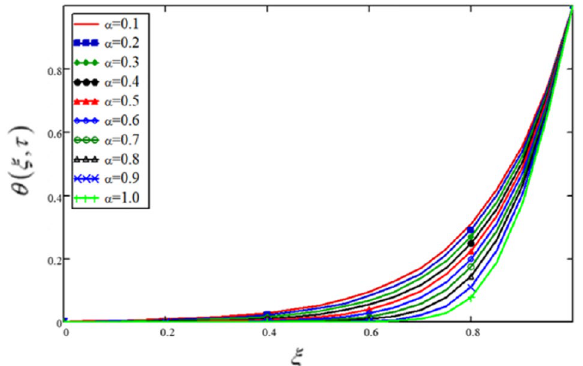
Figure 3. Variations in temperature profile for various values of fractional parameter, the profiles for α = 0.1, 0.2, 0.3, . . . , 1 ( α = 1 is the solution for the integer ordered